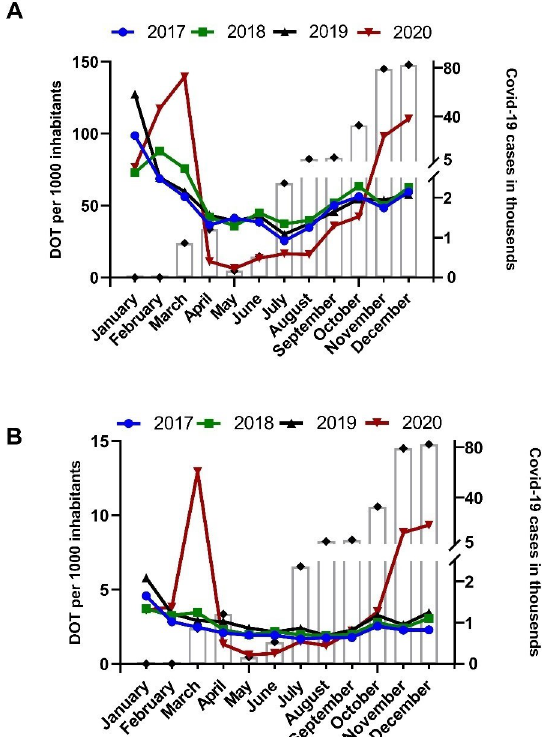
Fig 1. Days of therapy (DOT) units of azithromycin dispensed per month to non-hospital (panel A) and hospital (panel B) pharmacies in Croatia from 2017 to 2020. Open bars are number of COVID-19 cases. A strict lockdown